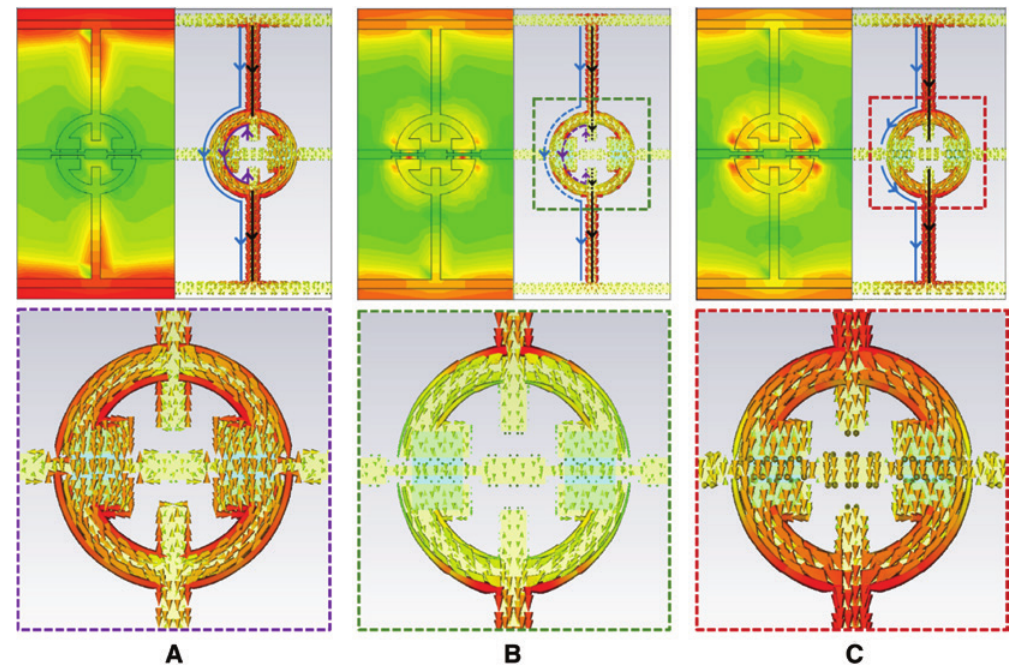
Figure 5: Simulation results of the electric field distribution and current density with different carrier density: (A) carrier density = 2 × 10 12 cm − 2 , (B) current density = 2 × 10 10 cm − 2 , and (C) carrier density = 2 × 10 5 cm − 2